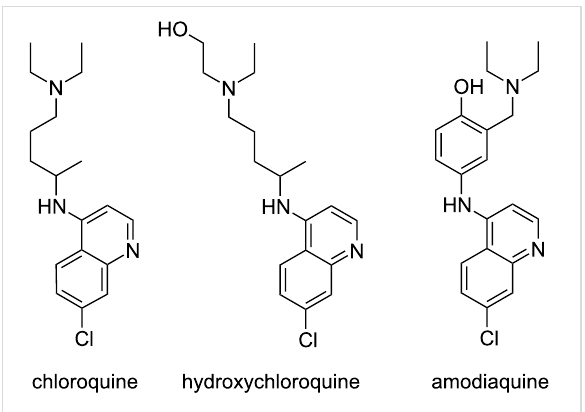
Figure 1: The structures of chloroquine, hydroxychloroquine, and amodiaquine.